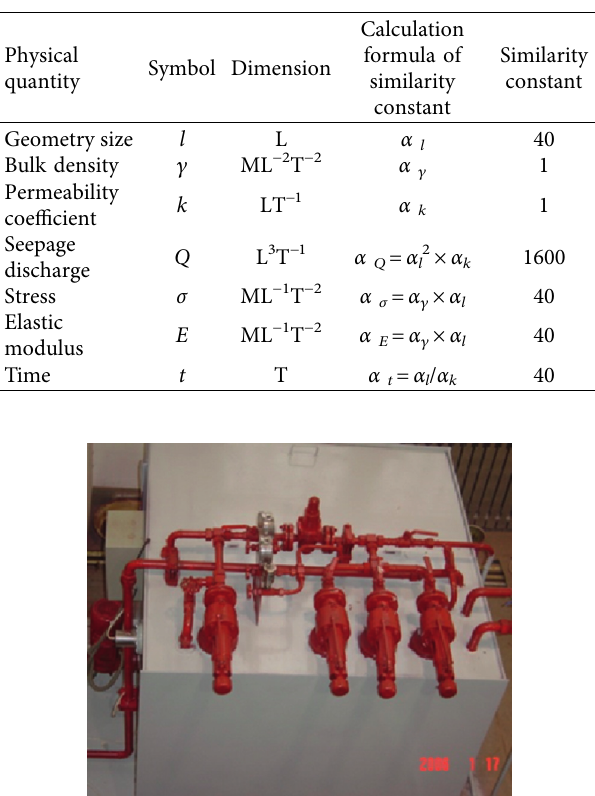
Figure 13: Hydraulic control system Table 2: Calculation table of similarity constants of physical quantities of the stress field and the seepage field.